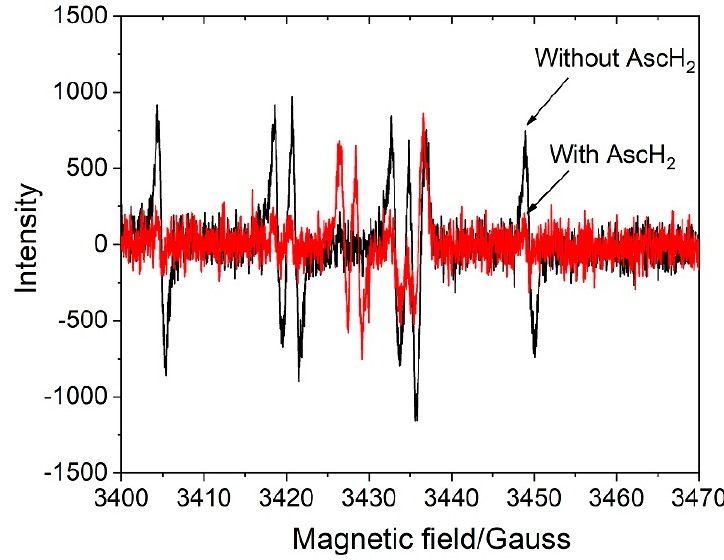
Figure 6. EPR spectra of TMIO–OH spin adduct in the absence (black) and presence (red) of 100 mM ascorbic acid in the presence of 12 mM L1; 20 mM TMIO; 3 mM FeCl 3 ; 12 mM H 2 O 2 ; pH = 3.0.